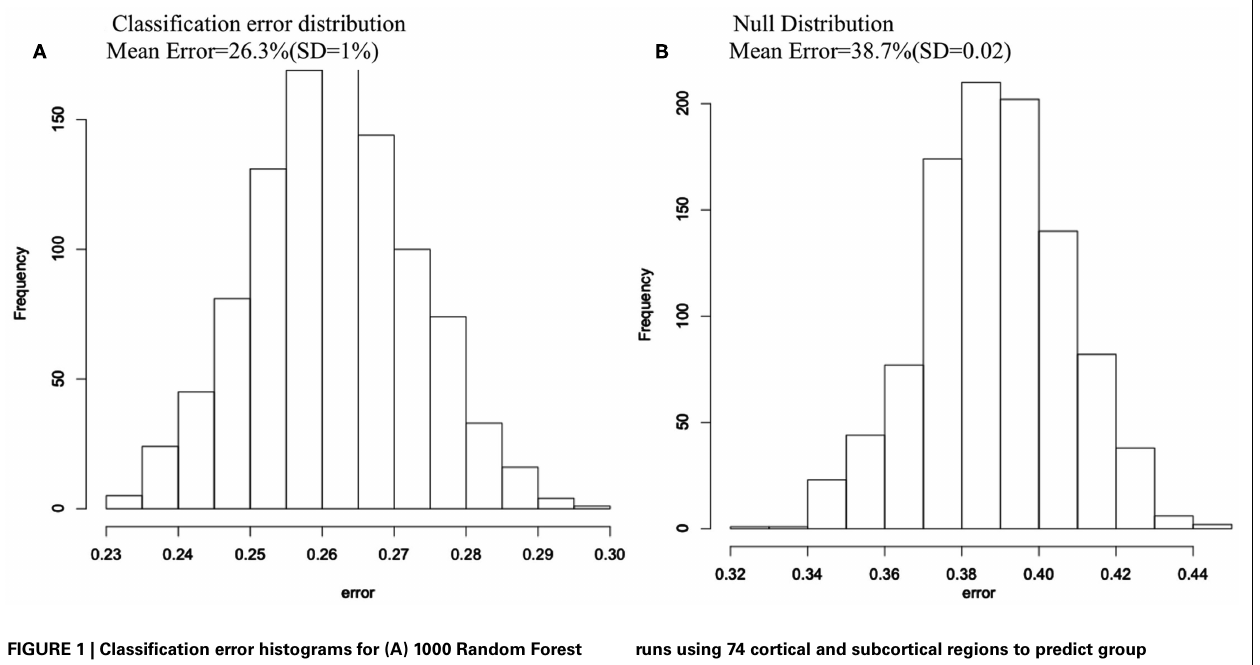
FIGURE 1 | Classification error histograms for (A) 1000 Random Forest runs using 74 cortical and subcortical regions to predict group membership for COS and control groups; (B) 1000 Random Forest